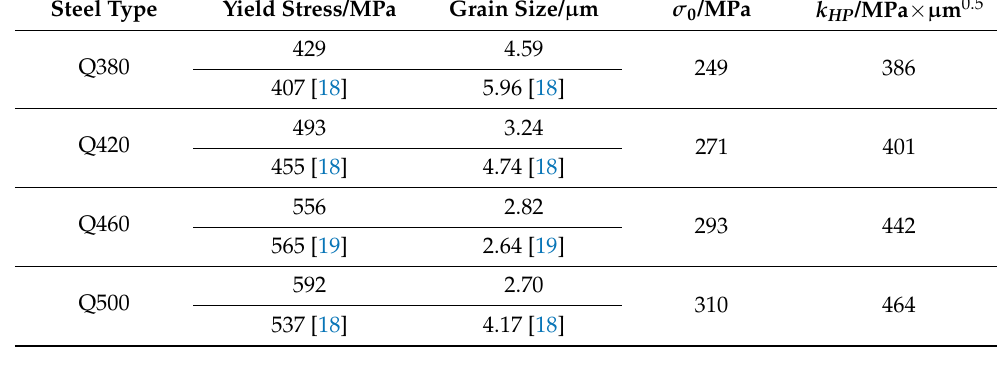
Table 2. Calculated parameters of Hall–Petch relationship for different steels.